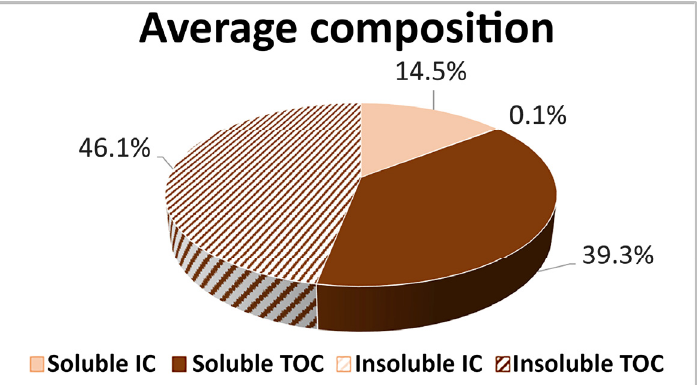
Figure 8. Relative composition of the samples. The soluble and insoluble carbonaceous fractions were in a ratio of about 1:1.